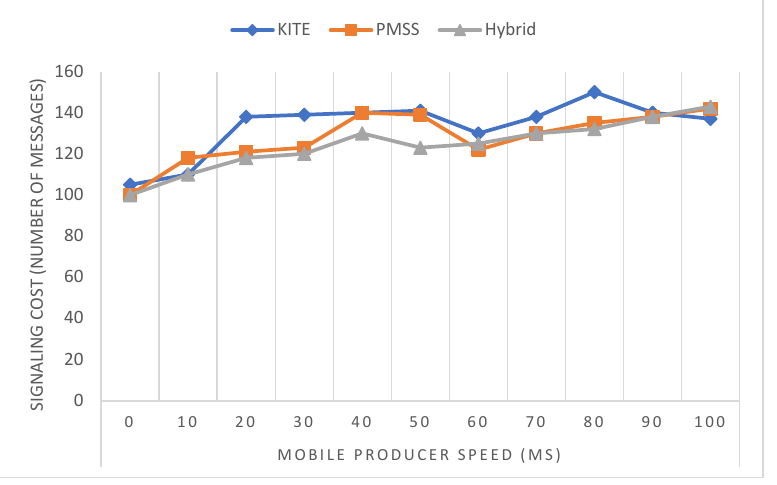
Figure 9. Signaling cost versus speed.